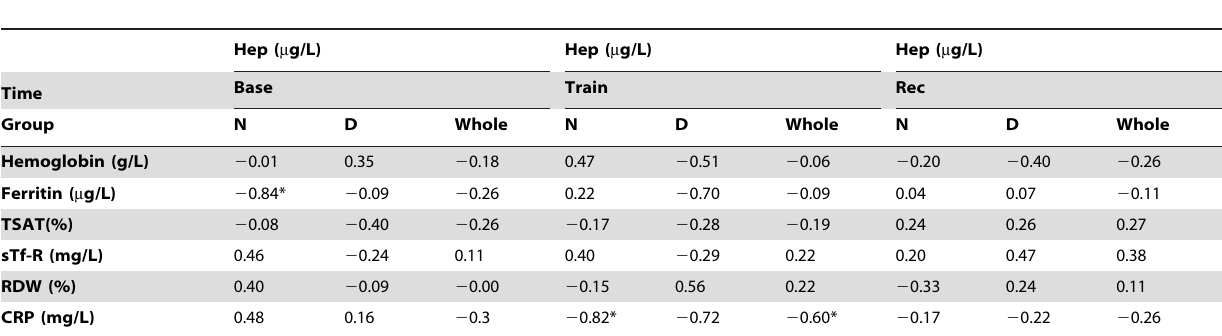
Hep ( m g/L) Hep ( m